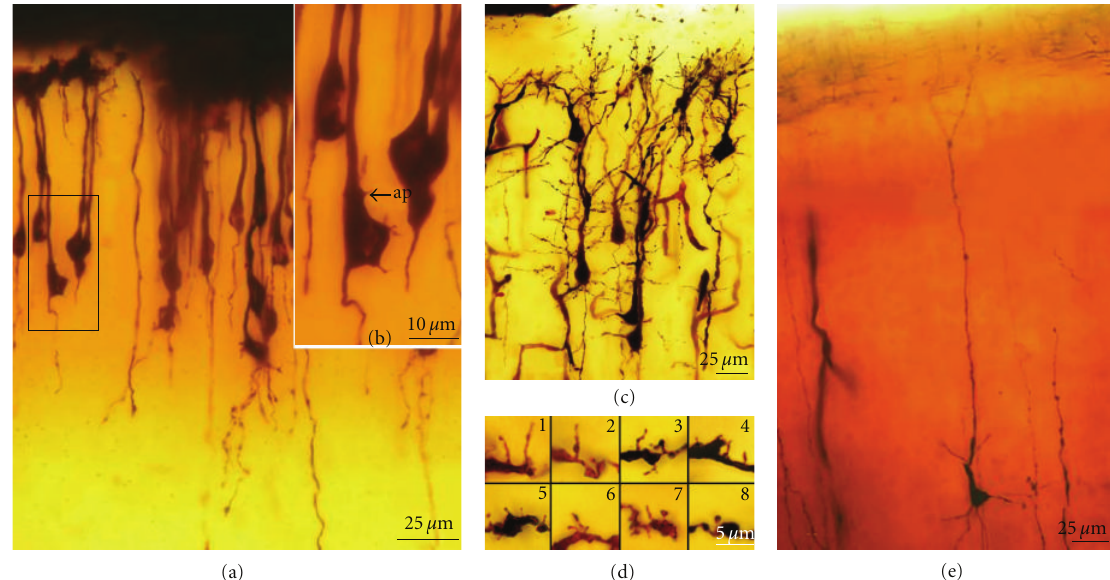
Figure 13: (a) Extended focus images of pyramidal cells, bipolar phase, neocortex, dog fetus, Cajal histological preparation, Golgi method. (b) Boxed region in (a) showing some appendages (ap) on the soma and the initial portion of the apical trunk. (c) Pyramidal cells, cerebral cortex, layers I–III, newborn rabbit, Cajal histological preparation, Golgi method. (d) Filopodia, protospines and dendritic spines, pyramidal cells showed in (c) 1: filopodia giving rise to protospines; 2 and 3: protospines; 4: filopodia; 5 and 6: thin dendritic spines; 7 and 8: mushroom dendritic spines. (e) Pyramidal cell, phase of appearance of basilar dendrites and collateral oblique dendrites of the apical trunk, neocortex, layer III, human fetus, Cajal histological preparation, Golgi